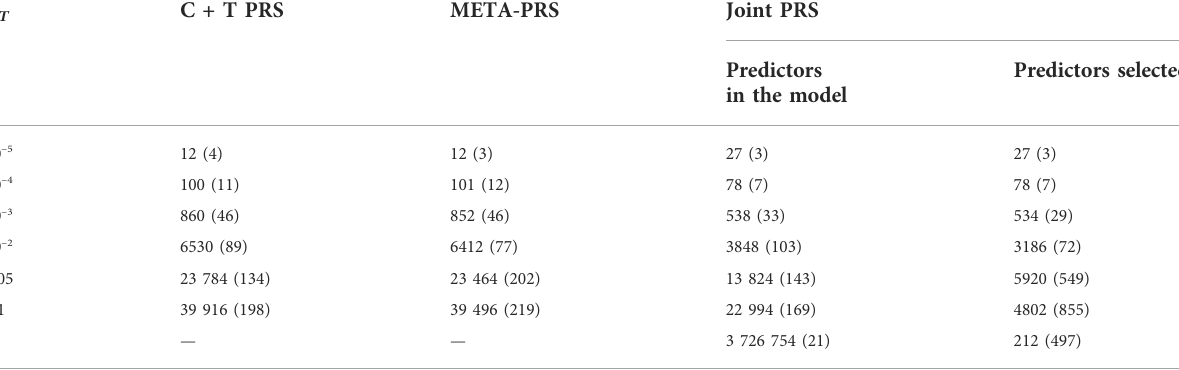
TABLE 4 Median and interquartile range for the number of SNPs included in different PRS models, as a function of p -value threshold P T . For each model and value of P T , numbersare the average result across ten repeated instances of 5-fold cross-validation. For the Joint PRS, we present the number of predictors that were entered into the model, in addition to the number of predictors selected after LASSO